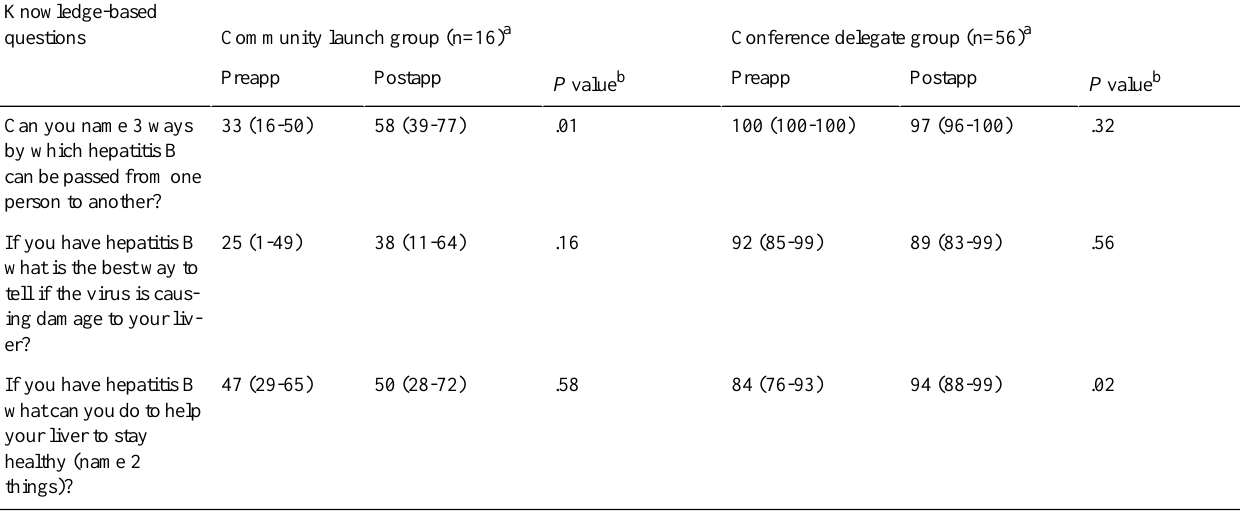
Conference delegate group (n=56) a Community launch group (n=16) a